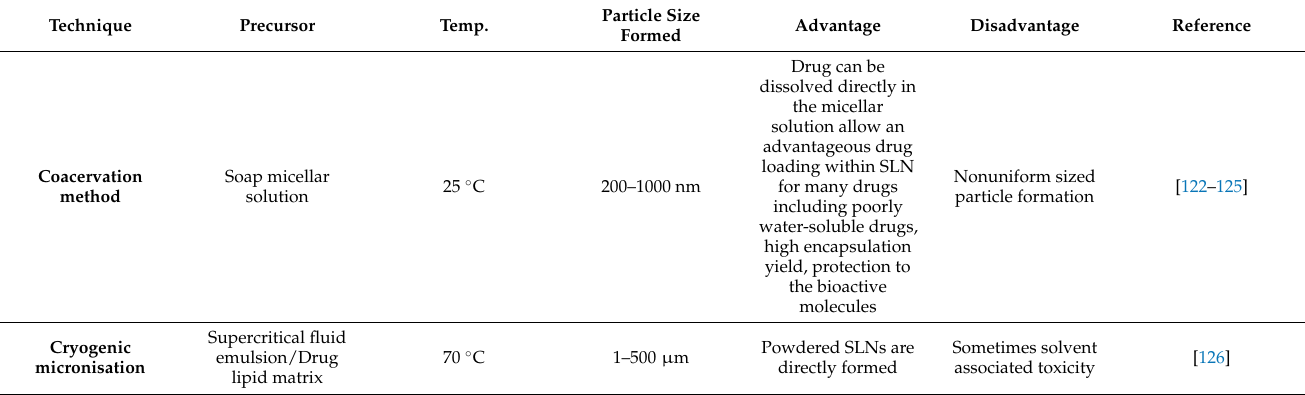
Table 3. Synthesis procedures for